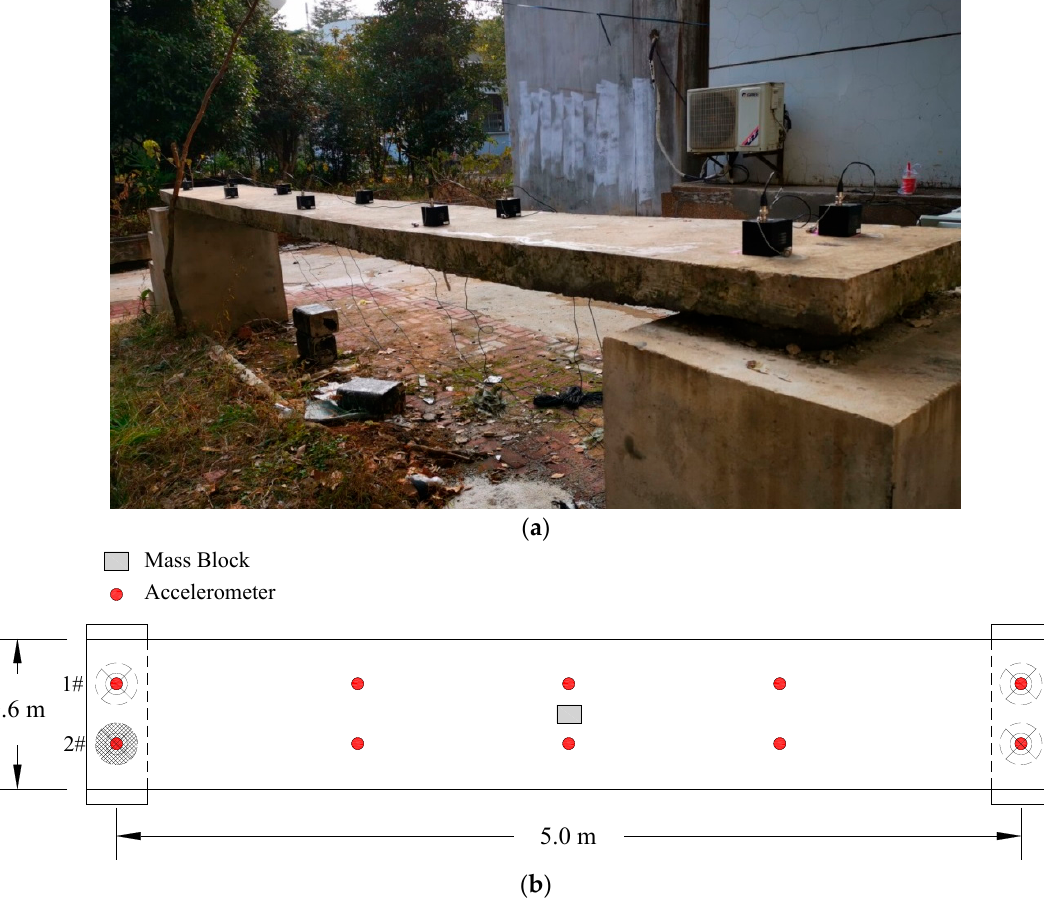
Figure 10. The simply supported reinforced concrete plate: ( a ) view of modal test; ( b ) layout of sensors and mass block.